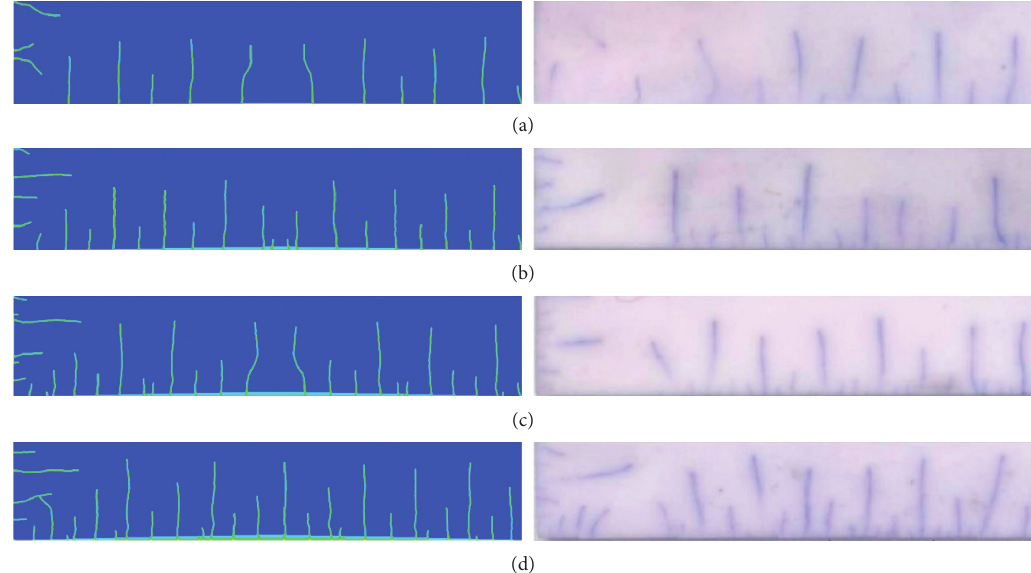
Figure 7: Thermal crack paths at different initial temperatures (left side: results predicted by the modified PD model in present work; right side: experimental results in [44]): (a) T 0 � 300 ° C; (b) T 0 � 350 ° C; (c) T 0 � 400 ° C; (d) T 0 � 500 °